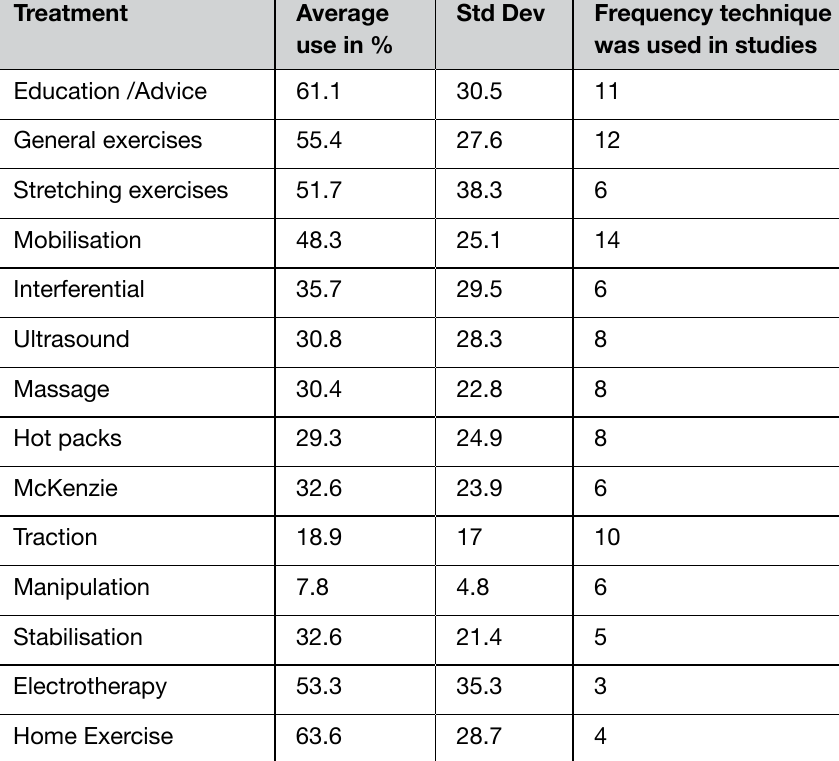
Table 2. Treatments used by physiotherapists The average percentage of use, standard deviation (Std Dev) and frequency with which an intervention was reported in